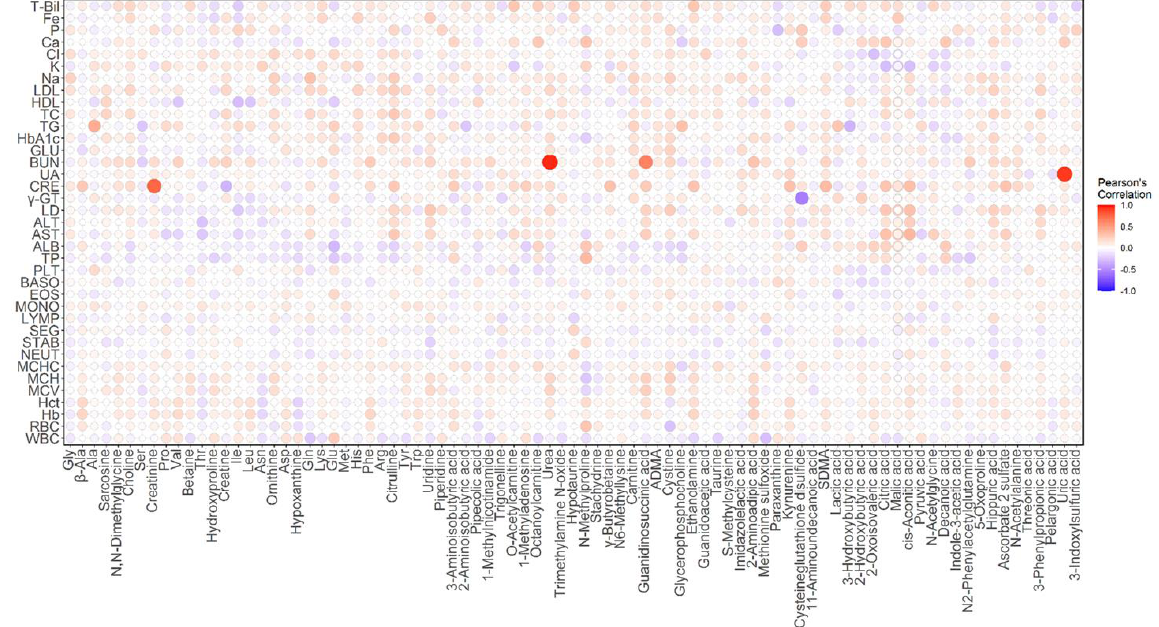
Figure 4. Heatmap of partial correlation coefficients between diagnostic blood tests and plasma metabolites. The colored bars gradually increase from white to blue for negative correlations and from white to red for positive correlations. The size of each spot changes according to the size of the correlation coefficient. Abbreviations in the figure are as follows: T-Bil: total bilirubin; Fe: serum iron; P: inorganic phosphorus; Ca: calcium; Cl: chlorine; K: potassium; Na: sodium; LDL: low-density lipoprotein cholesterol; HDL: high-density lipoprotein cholesterol; TC: total cholesterol; TG: triglycerides; HbA1c: hemoglobin A1c; GLU: glucose; BUN: blood urea nitrogen; UA: uric acid; CRE: creatinine; γ -GT: gamma-glutamyl transpeptidase; LD: lactate dehydrogenase; ALT: alanine transaminase; AST: aspartate aminotransferase; ALB: albumin; TP: total protein; PLT: platelet count; BASO: basophil; EOS: eosinophil; MONO: monocyte; LYMP: lymphocyte; SEG: segmented cell; STAB: stab cell; NEUT: neutrophil; MCHC: mean corpuscular hemoglobin concentration; MCH: mean corpuscular hemoglobin; MCV: mean corpuscular volume; Hct: hematocrit; Hb: hemoglobin; RBC: red blood cell count; WBC: white blood cell